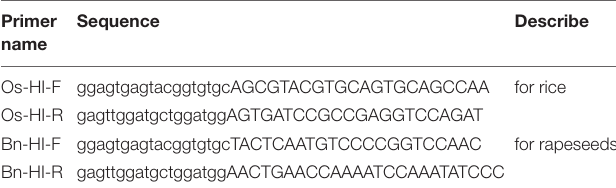
TABLE 2 | The primers used in NGS-based